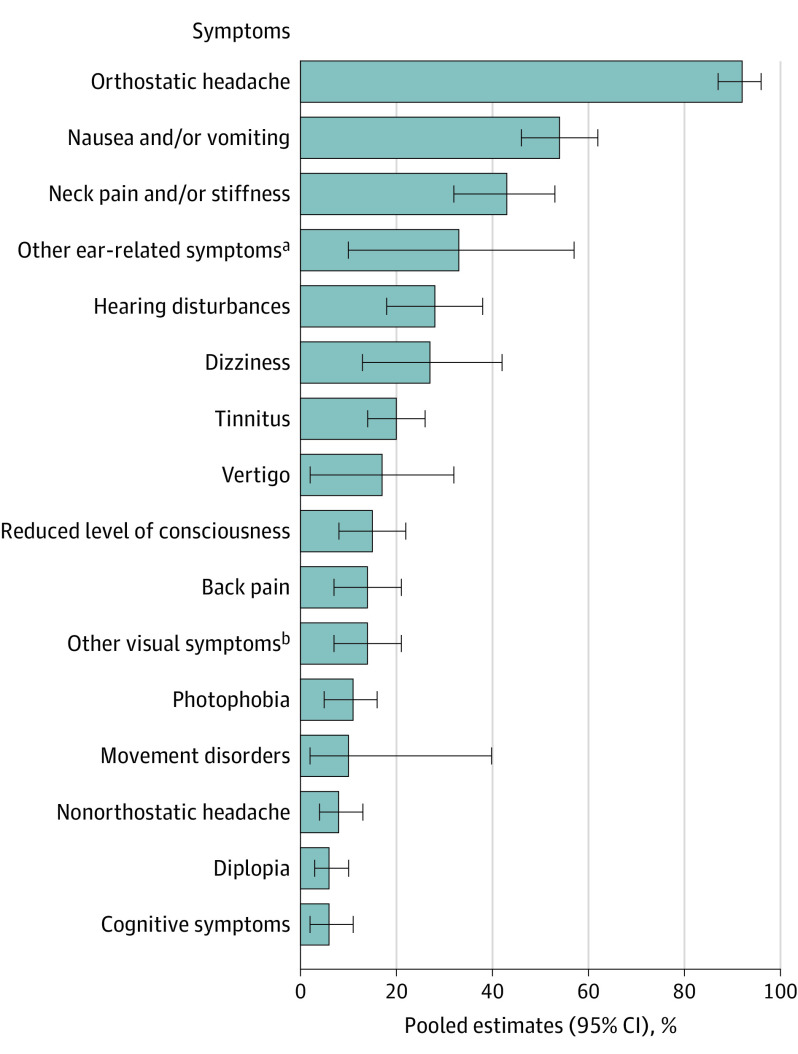
Signs and Symptoms of Spontaneous Intracranial HypotensionPercentages indicate the pooled estimates of proportions.aOther ear-related symptoms included aural fullness, hyperacusis, or unspecified.bOther visual symptoms included blurred vision, nystagmus, and/or visual loss.